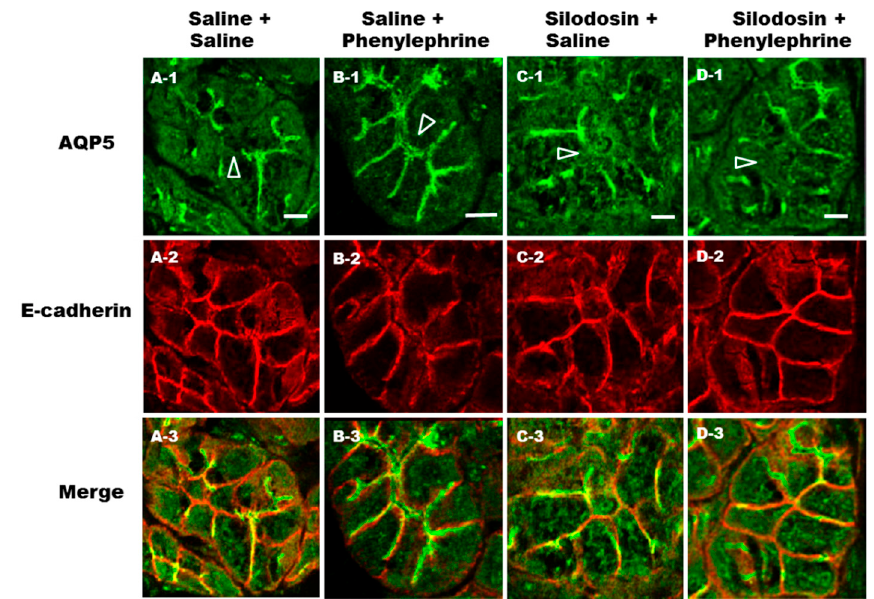
Figure 4. Immunohistochemical analysis of AQP5 and E -cadherin distributions in rat parotid acinar cells after phenylephrine and silodosin administration. Rats were treated with silodosin (a daily dose of 1 mg/kg p.o.) ( C and D ) or saline ( A and B ) once daily for 1 week. Subsequently, phenylephrine (0.25 mg/kg) ( B and D ) or saline ( A and C ) was intravenously injected and parotid glands were subjected to immunohistochemical analysis with anti-AQP5 and anti- E -cadherin antibodies. Secondary antibodies coupled to Alexa-488 or 568 were used to visualize AQP5 ( A-1 to D-1 ) and E -cadherin ( A-2 to D-2 ), respectively. Arrow heads indicate APM. Scale bars: 10 µm.